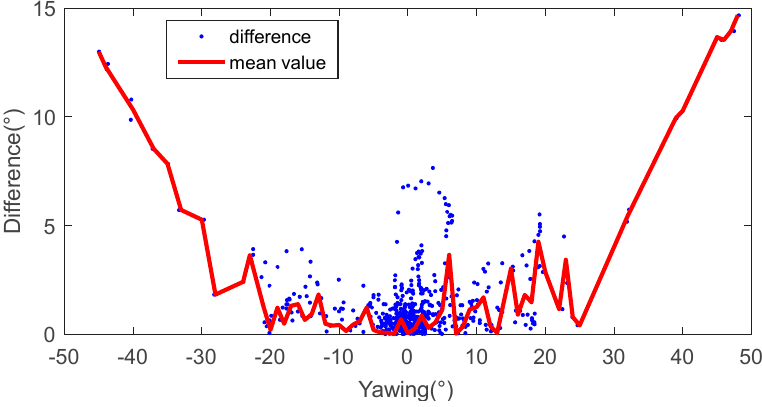
Figure 11. The absolute difference between the two tracking systems against different yawing angles from the in-house experiments.